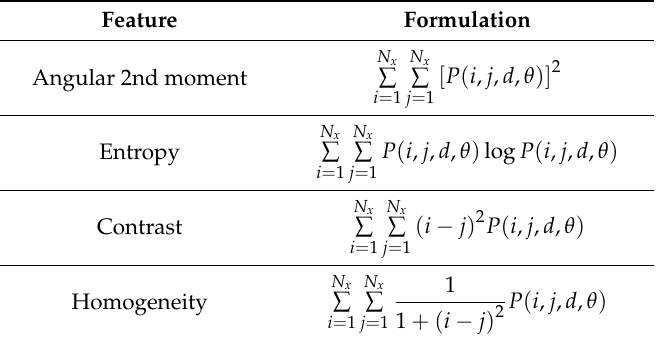
Table 2. Mathematical formulations of GLCM features.